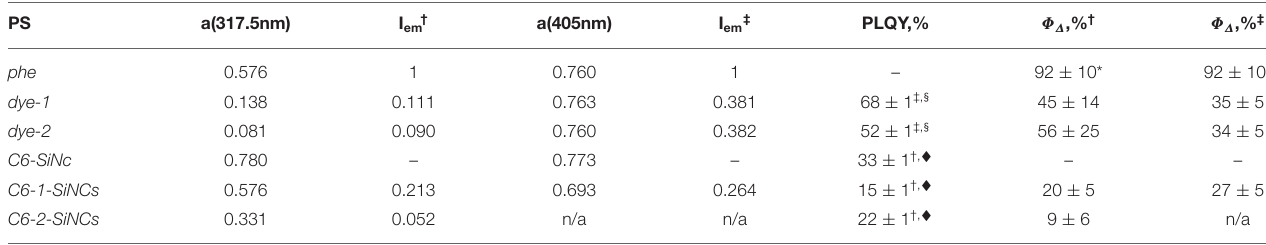
TABLE 1 | Absorbance ( α ), normalized intensity of 1 O 2 phosphorescence ( I em ), photoluminescence quantum yield ( PLQY ), and singlet oxygen quantum yields ( Φ ∆ ) measured with 317.5nm and 405nm